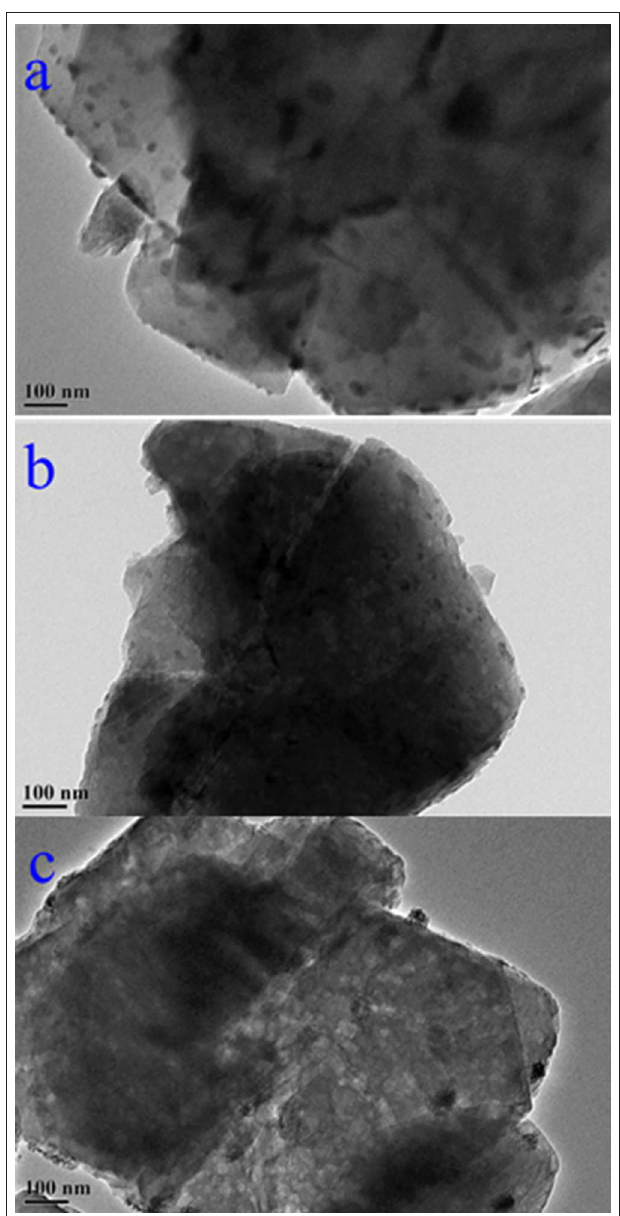
FIGURE 3 | TEM images of Mn/NaY (a) , Mn/USY (b) and Mn-USY (c) .